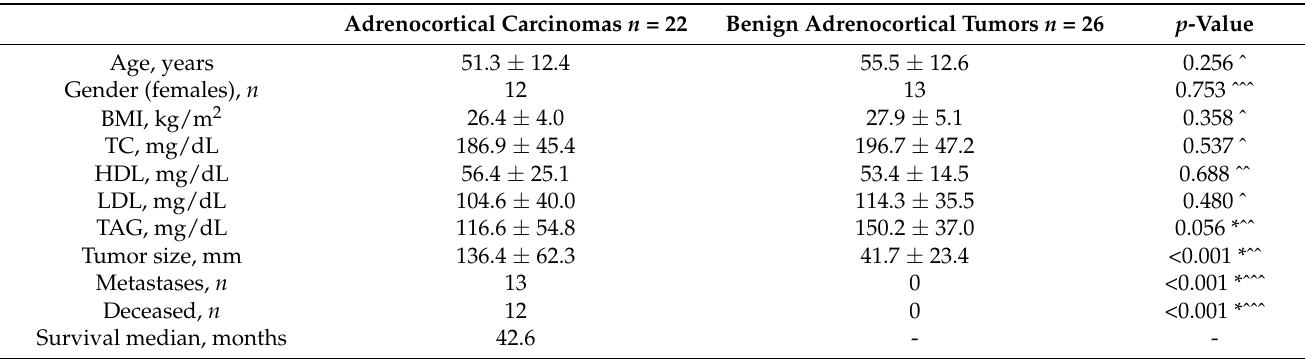
Table 1. Comparison of clinical characteristics of patients with adrenocortical carcinomas and benign adrenocortical tumors (data presented as mean ± standard deviation).